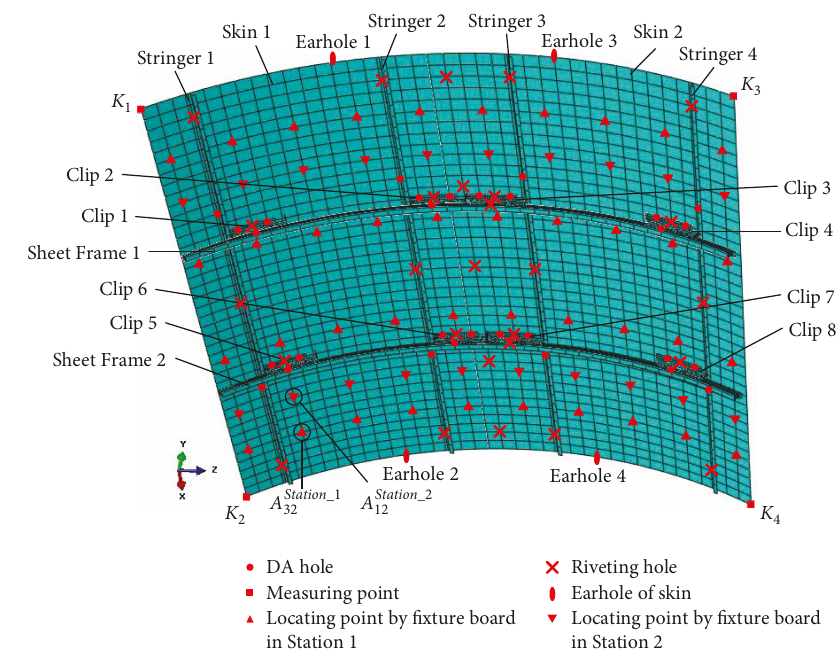
Figure 6: FE model of an aircraft panel. Table 1: Tolerance schemes of parts and fi